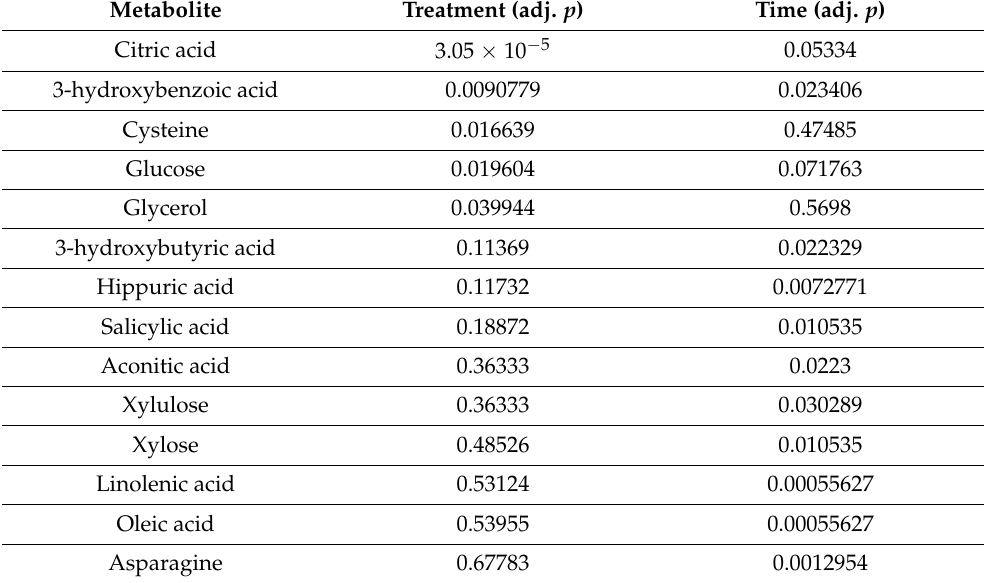
Table 12. Effects of Time or Treatment on Equine Agmatine Plasma Metabolite Levels. Adjusted p -values (adj. p ) for the effects of treatment (agmatine 1st, 15th, 30th days; control 15th day) and time (0, 30, 60, 120, minutes, 5, 24 h) on plasma levels of the indicated agmatine metabolites.